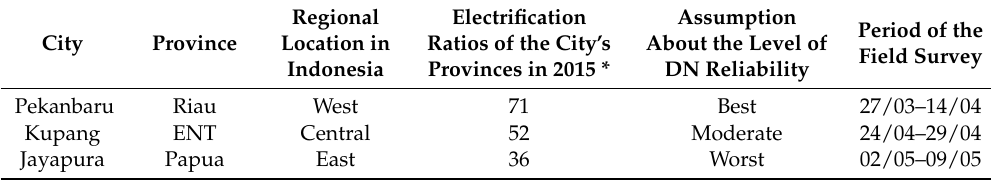
Table 1. Study locations and reasons for